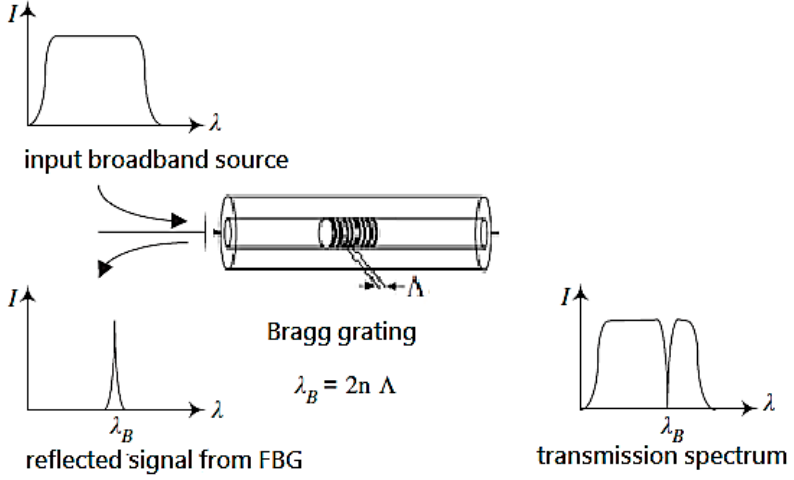
Figure 1. Transmission and reflectance spectrum from fiber Bragg grating.